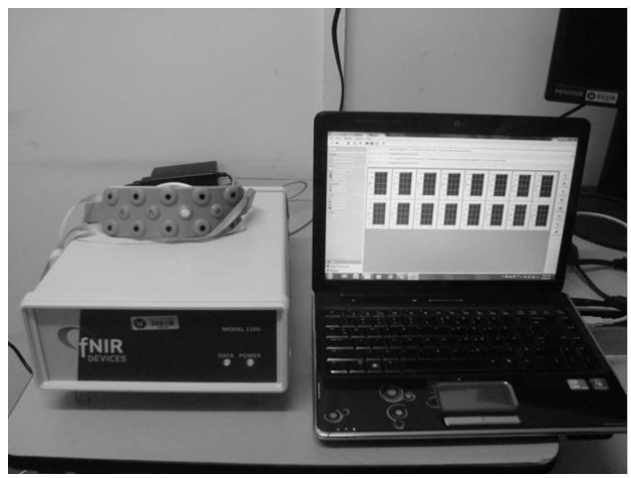
Figure 1. fNIRS device used (Biopac Systems ® - 16 voxels; 10 photo detectors; 4 photo emitters; 2.5 mm inter optode distance).